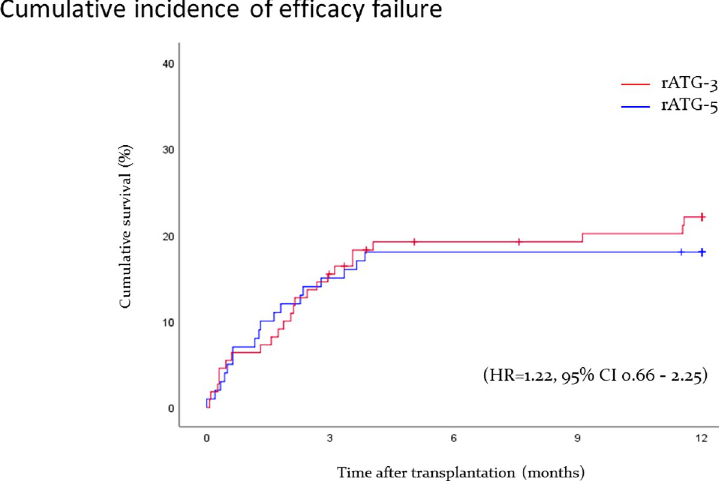
Fig 1. Cumulative survival-free of efficacy failure (first biopsy proven acute rejection, graft loss, death), in patients undergoing retransplantation receiving 5 or 3 mg/kg rATG induction therapy.